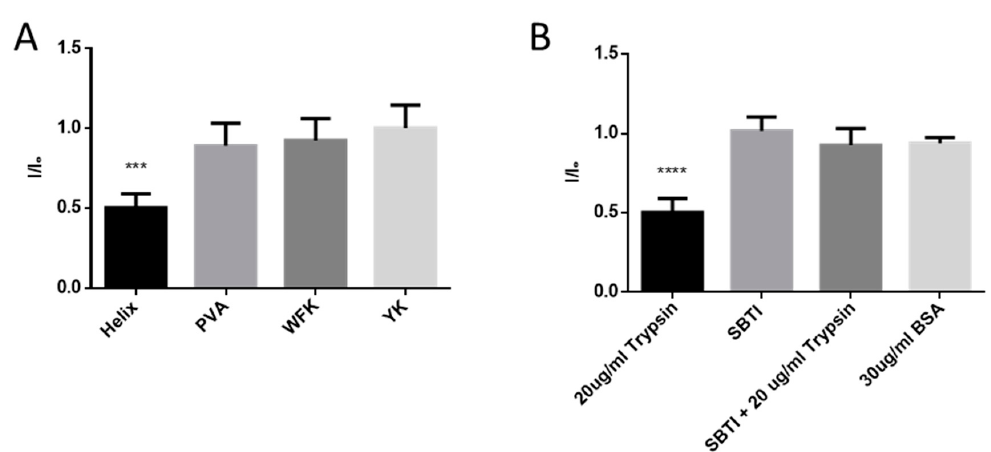
Figure 5. Trypsin effect on the sensors PL. ( A ) The PL levels of four different SWCNTs sensors after incubation with 20 µg/mL trypsin for 3 h as compared to initial PL value ( p < 0.05, n = 5). ( B ) Comparing change in PL after incubation of the Helix sensor with 20 µg/mL trypsin for 3 h, in the presence or absence of trypsin inhibitor (SBTI). A total of 30 µg/mL of BSA served as a negative control. (One-way ANOVA, *** and **** p < 0.05, n = 4.) Error bars represent standard deviation (SD).